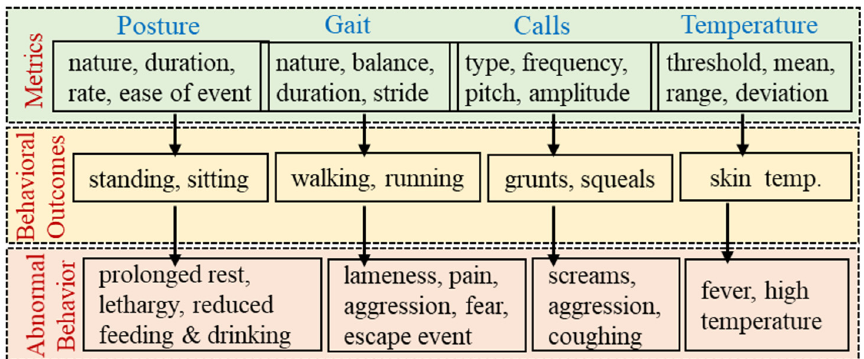
Figure 5. Flowchart for metrics, behavioral outcomes, and indicators of poor